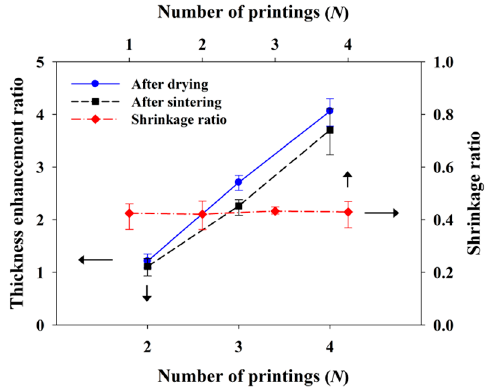
Figure 13. Ratio of thickness enhancement after drying and shrinkage after sintering in the morphology of inkjet-printed lines on S 50 substrate for different numbers of printings at 125 °C substrate temperature.